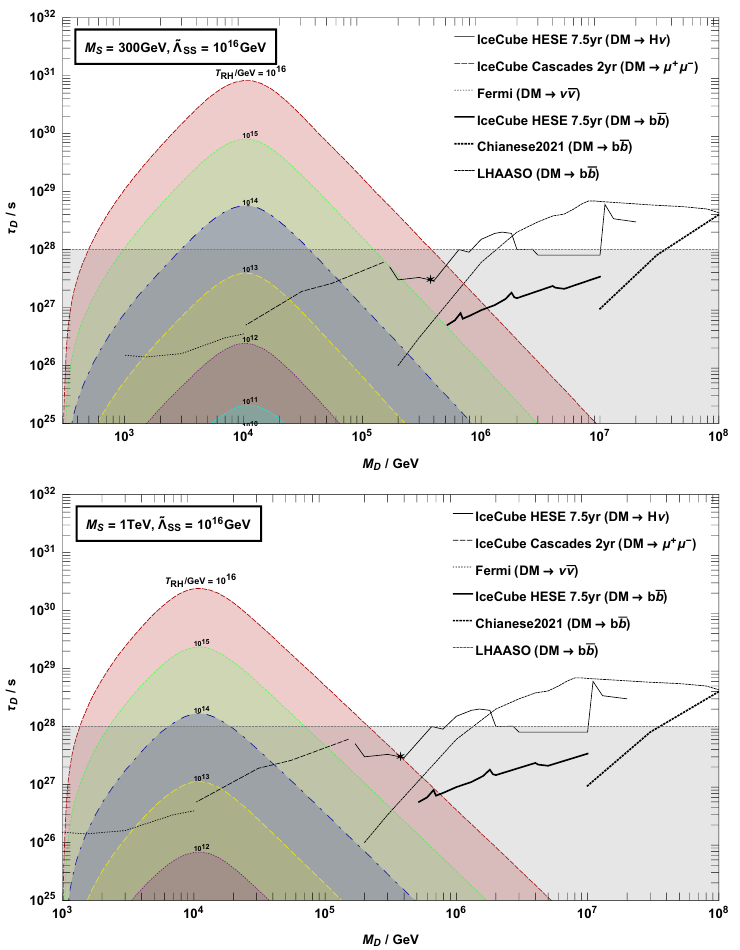
Figure 5 . Allowed regions in the lifetime versus mass plane for a fixed value ˜Λ SS = 10 16 GeV , for the indicated values of T RH and for M S = 300 GeV (upper panel), 1 TeV (bottom